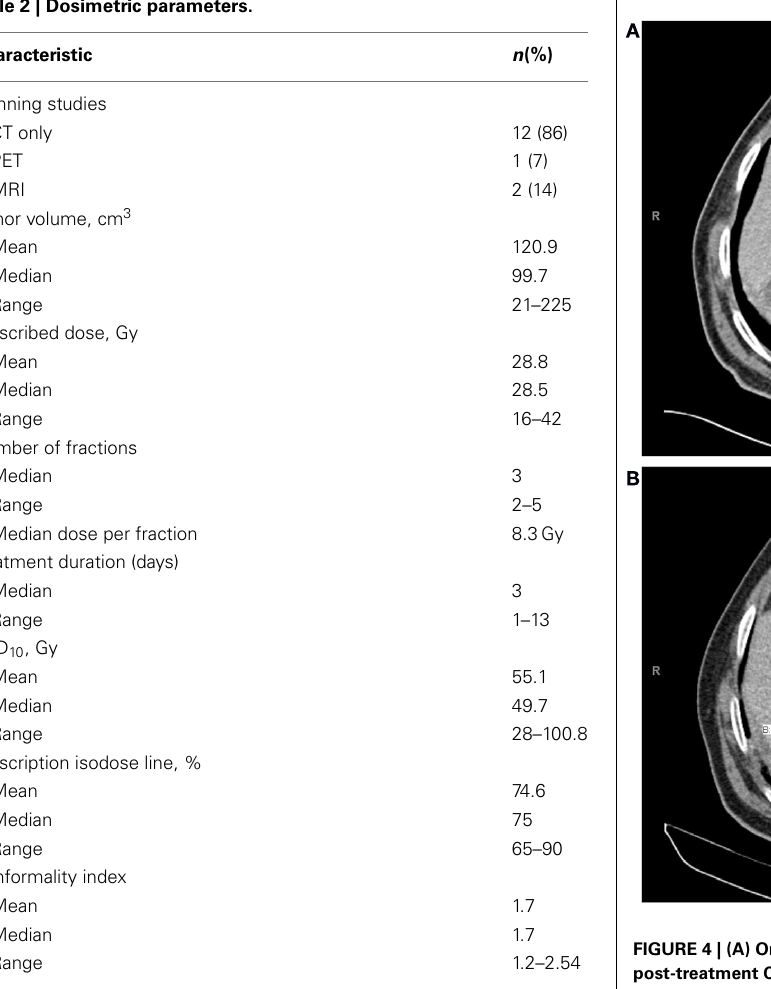
Table 2 | Dosimetric parameters.